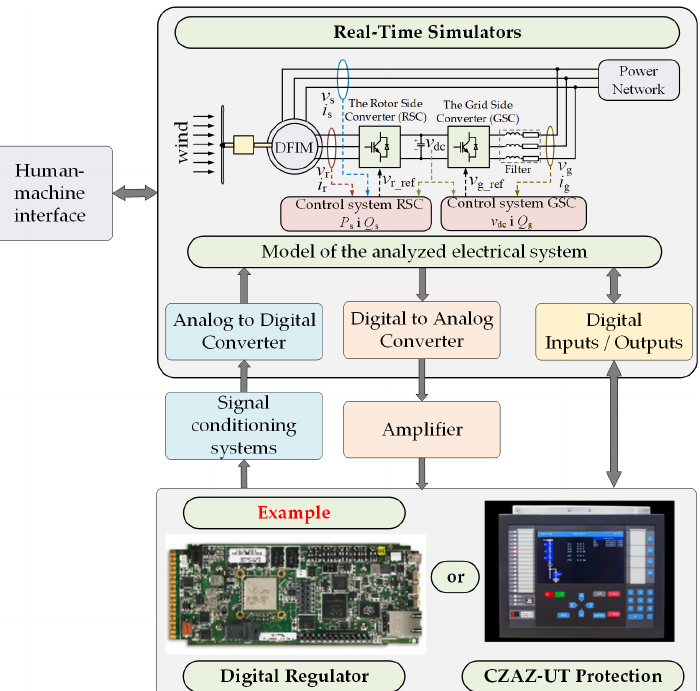
Figure 1. Schematic diagram of a real-time